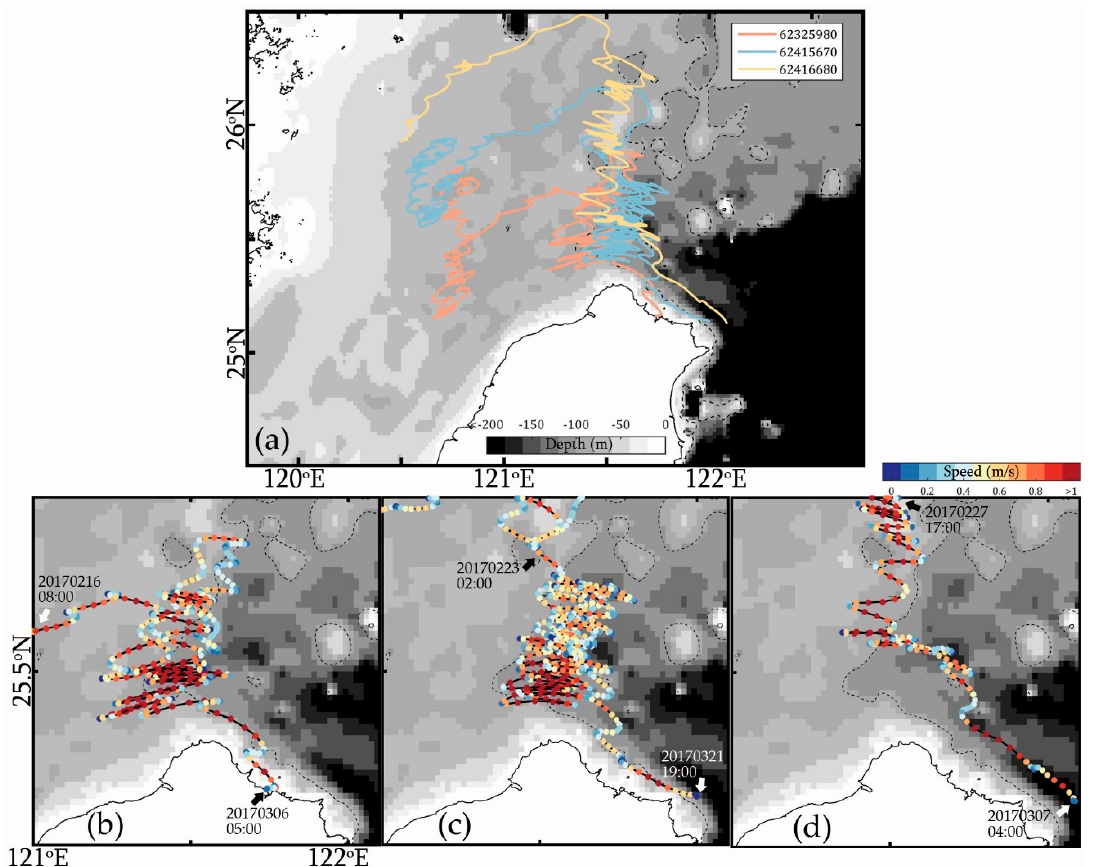
Figure 5. ( a ) Three trajectories of drifters in the Taiwan Strait in winter. ( b ) ID : 62325980, ( c ) ID : 62415670, and ( d ) ID : 62416680.